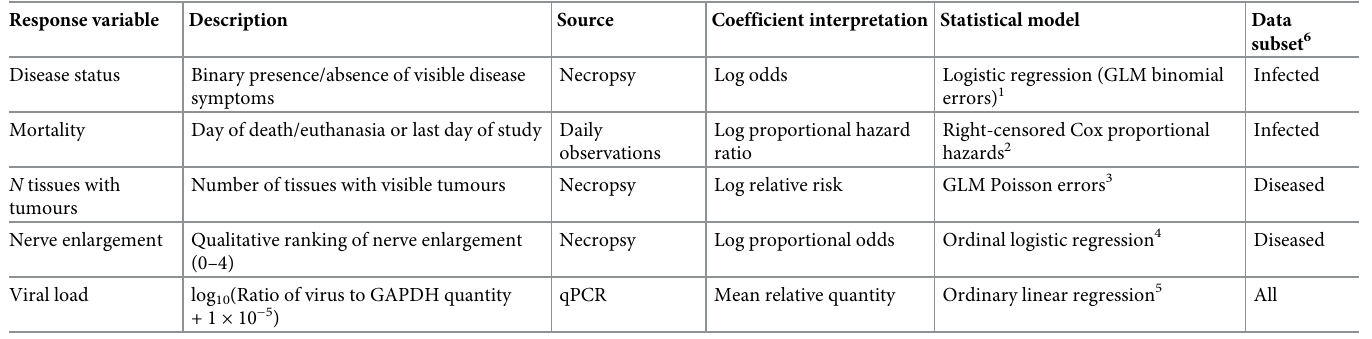
Table 3. Summary of modelled response